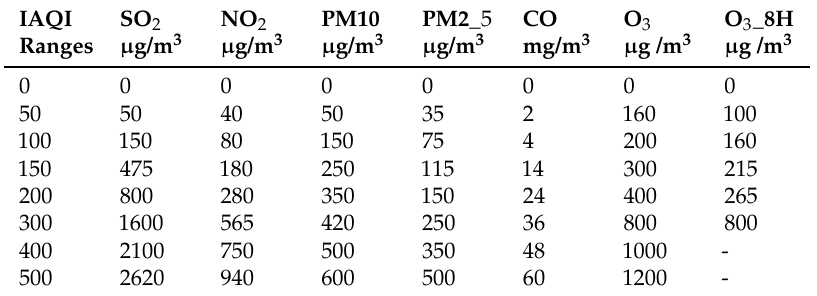
Table 3. Individual Air Quality Index and corresponding pollutants’ concentration